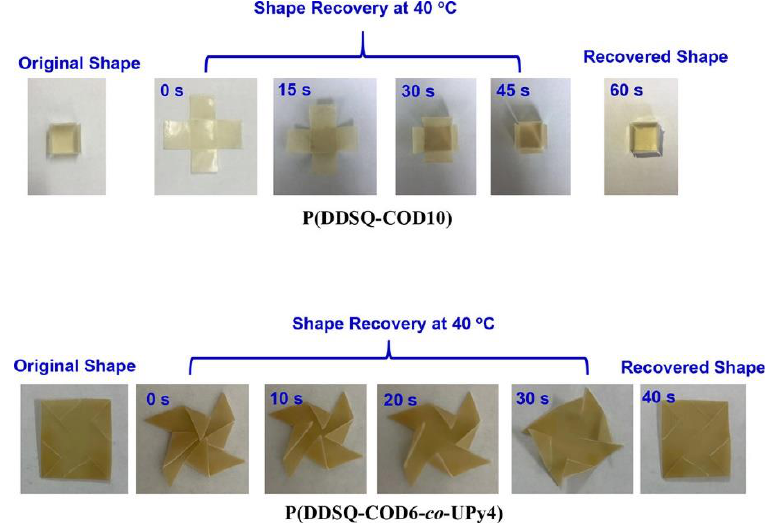
Figure 8. Shape recovery of hybrid polymers P(DDSQ-COD10) and P(DDSA-COD6- co -UPy4) at 40 ◦ C. Reprinted with permission from Macromolecules 2020, 53, 7119–7131. Ref. [70] Copyright (2020) American Chemical Society.